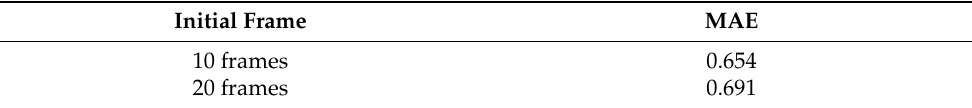
Table 2. Results of user-satisfaction prediction of SVR model using initial frame.